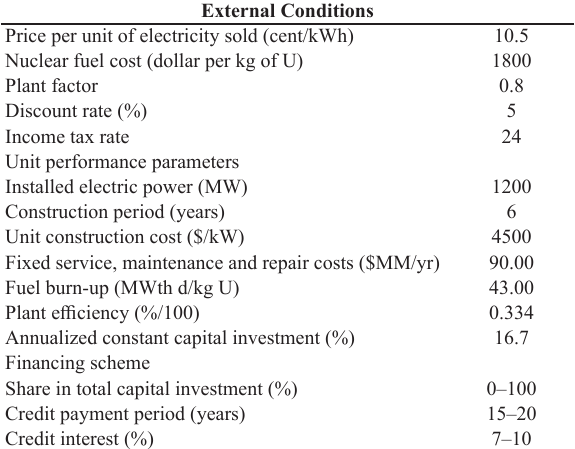
Figure 1. Change in NPV with